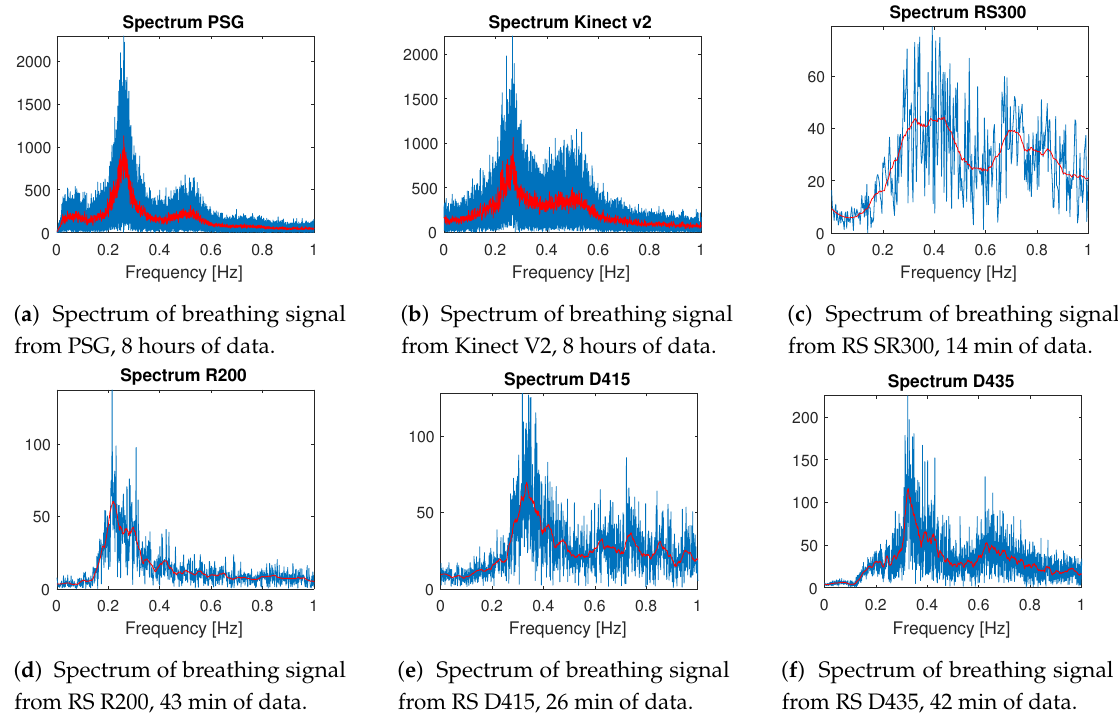
Figure 1. Comparison of spectral analysis of 8 hour records from ( a ) PSG, ( b ) MS Kinect v2 resampled to 10 Hz and ( c – f ) shorter signals from RealSense depth